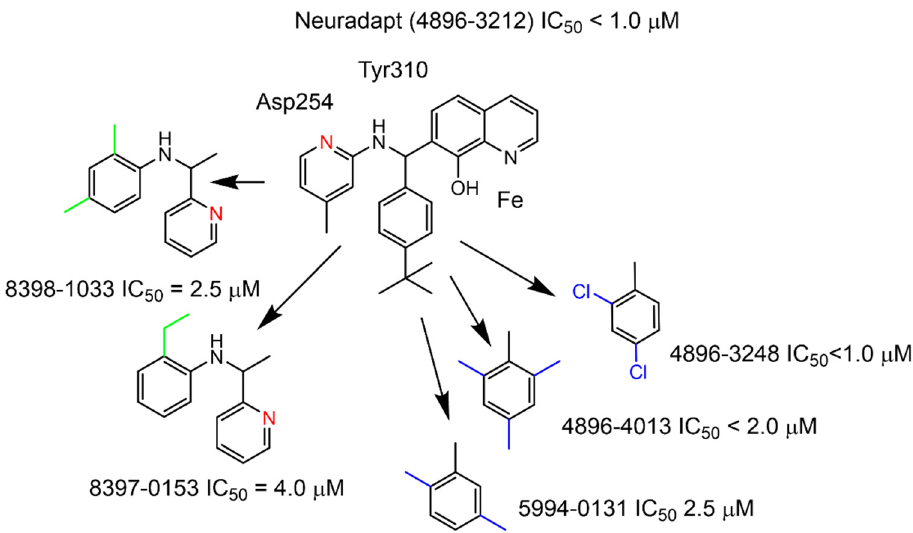
Figure 3. Structure–activity relationships derived from the titration experiments. All compounds are commercially available from ChemDiv (Skolkovo, Russia).